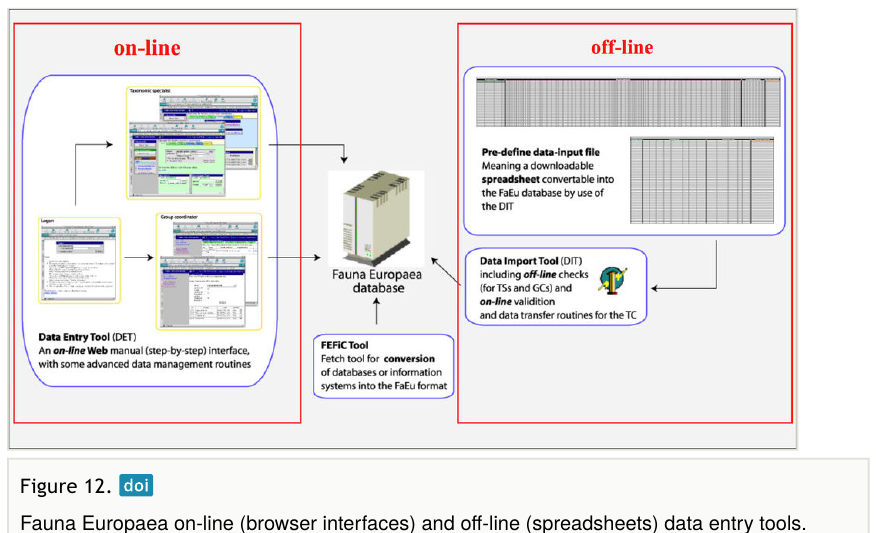
Fauna Europaea on-line (browser interfaces) and o ff -line (spreadsheets) data entry